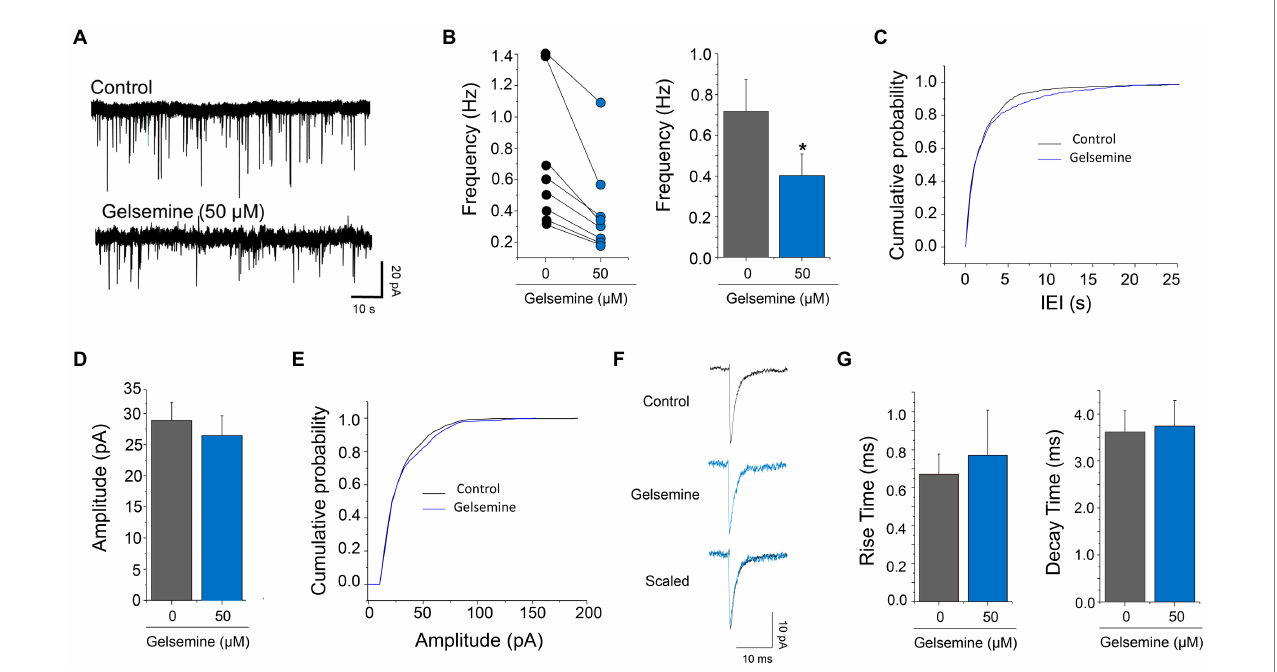
FIGURE 3 Actions of gelsemine on glutamatergic neurotransmission. (A) Examples of current traces showing the glutamatergic synaptic activity before and during the application of 50 μ M gelsemine. (B) The scatter graph and the bar plot depict the effect of 50 μ M of gelsemine on the frequency of synaptic events in 8 neurons. The average frequency of glutamatergic mEPSC was significantly diminished by gelsemine. * p < 0.05, paired Student t -test. (C) Cumulative probability distribution of the inter-event intervals of mEPSCs in the absence or the presence of 50 μ M of gelsemine. The distribution was significantly altered by the alkaloid. p < 0.0001; Kolmogorov–Smirnoff test. (D) The bar plot summarizes the effects of gelsemine on the amplitude. The amplitude was not significantly diminished by gelsemine. p = 0.98, paired Student t -test. (E) Cumulative probability distribution of the amplitudes of mEPSCs in the absence or the presence of 50 μ M of gelsemine. Differences were not significant (Kolmogorov–Smirnoff test). (F) Average glutamatergic current traces before and during the application of 50 μ M of gelsemine. (G) The bar plot summarizes the effects of gelsemine on rise time and decay time of glutamatergic mEPSCs. Differences were not